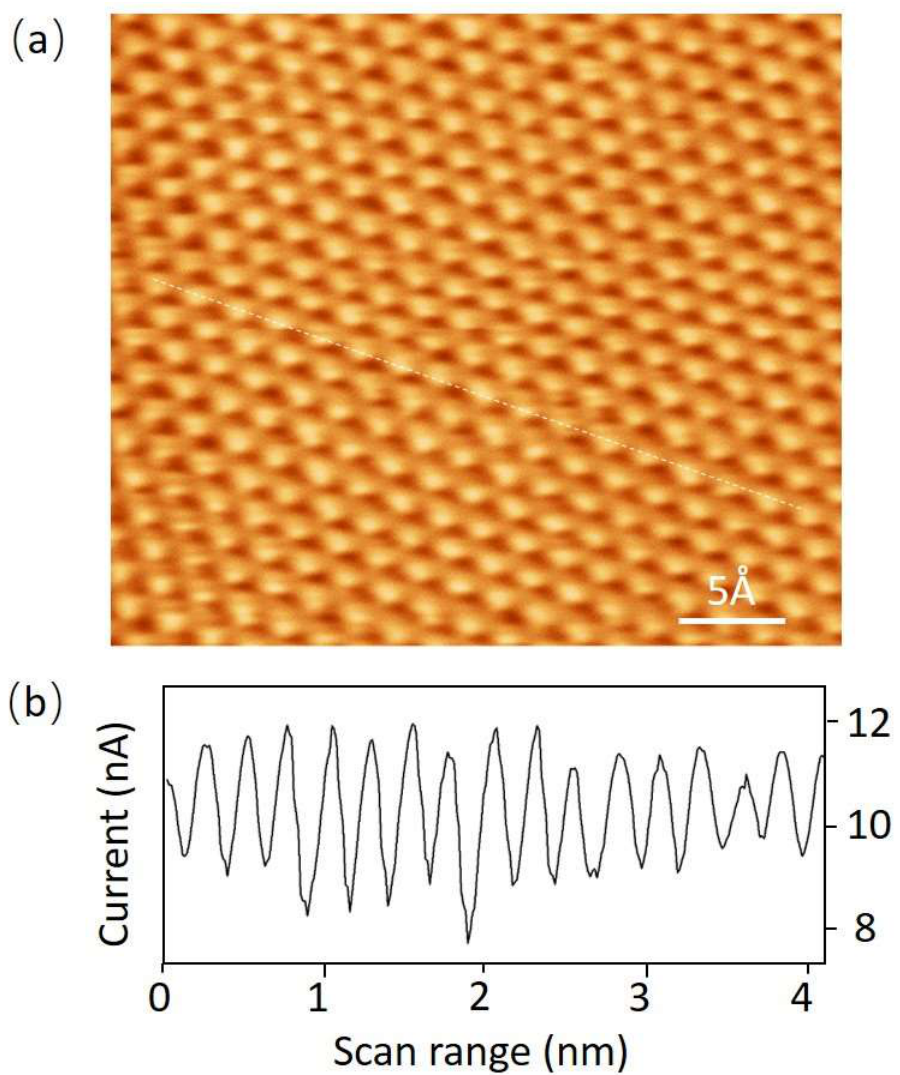
Figure 2. ( a ) Atomic-resolution image of large-sized graphite obtained with constant height mode. The average tunneling current is 10 nA and the scan speed is 7 lines/s. ( b ) The tunneling current profile obtained along the white line in ( a ).